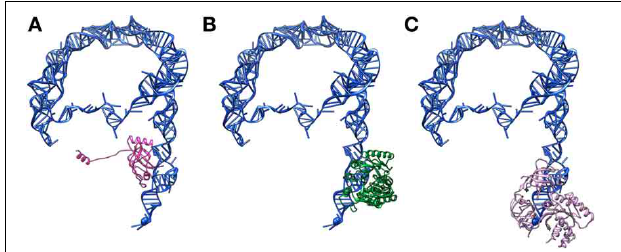
FIGURE 6 | The tRNA-like domain is the primary binding site for most tmRNA protein partners. (A) Atomic model of the tmRNA-SmpB complex based on PDB entry 4ABR, and EMDB entry EMD-1312. tmRNA is blue and SmpB is magenta. (B) Atomic model of the tmRNA-TrmA complex based on PDB entries 4ABR and 2OB7, and EMDB entry EMD-1312. tmRNA is blue and TrmA is green. (C) Atomic model of the tmRNA-EF-Tu complex based on PDB entry 4ABR and EMDB entry EMD-1312. tmRNA is blue and EF-Tu is